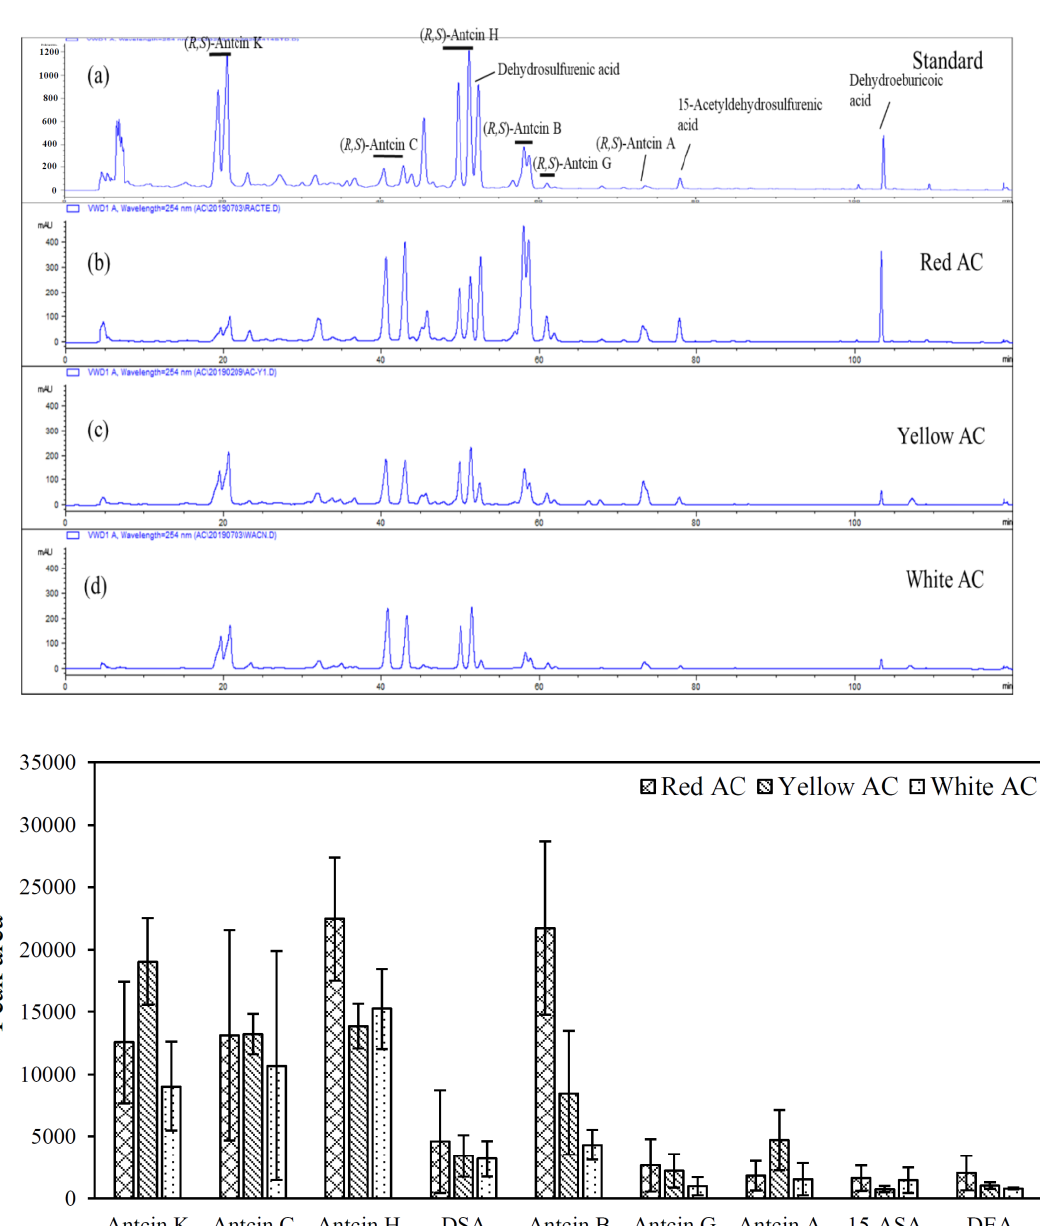
Figure 3. Representative HPLC profiles and peak areas of bioactive triterpenoid (index) compounds in fruiting bodies of different A. cinnamomea phenotypes collected from the wild. ( A) . Representative HPLC profiles: ( a ) standard, ( b ) red AC, ( c ) yellow AC, and ( d ) white AC. ( B ). The peak area represents the concentration of the compound integrated and calculated automatically by the computer of the HPLC system. DSA = Dehydrosulfurenic acid; 15-ASA = 15-Acetyldehydrosulfurenic acid; DEA = Dehydroeburicoic acid.